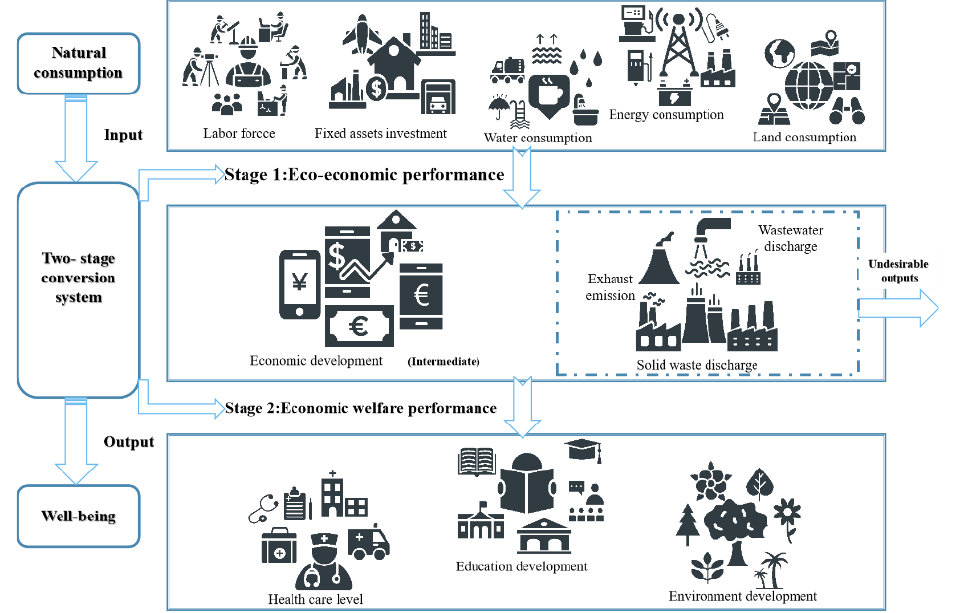
Figure 2. The network structure of the two-stage ecological well-being transformation system. In Equation (6), EWP is the ecological well-being performance. GDP reflects the level of economic development. WB represents the comprehensive well-being level, including education, health care, and environmental development levels. EI represents the ecological resource